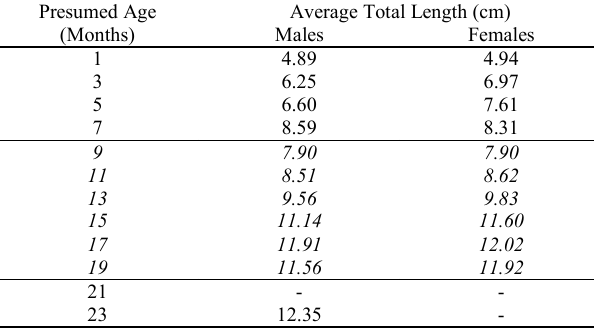
Table 4. Average total length of males and females of Atherinella brasiliensis in a presumed series of modal progression (Figures 2 and 3). Age values are month from peak reproduction (November) as reported by Bervian & Fontoura (1997). In italics is a progression series of the same age group, used for growth curve estimation.